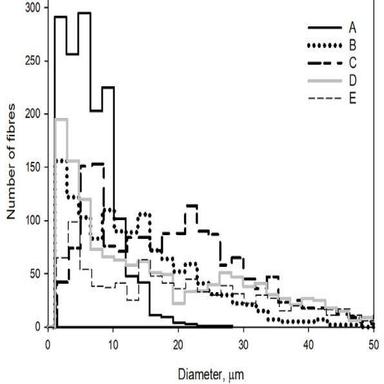
Fibre diameter distributions of melt electrospun mats obtained from various polymers (A - Vestamid™ L 1600; B - Vestamid™ L 1901; C - Arnitel® 3106; D - Rilsamid® AMN 0 TLD; E − Pebax® 35R53 SP 01).